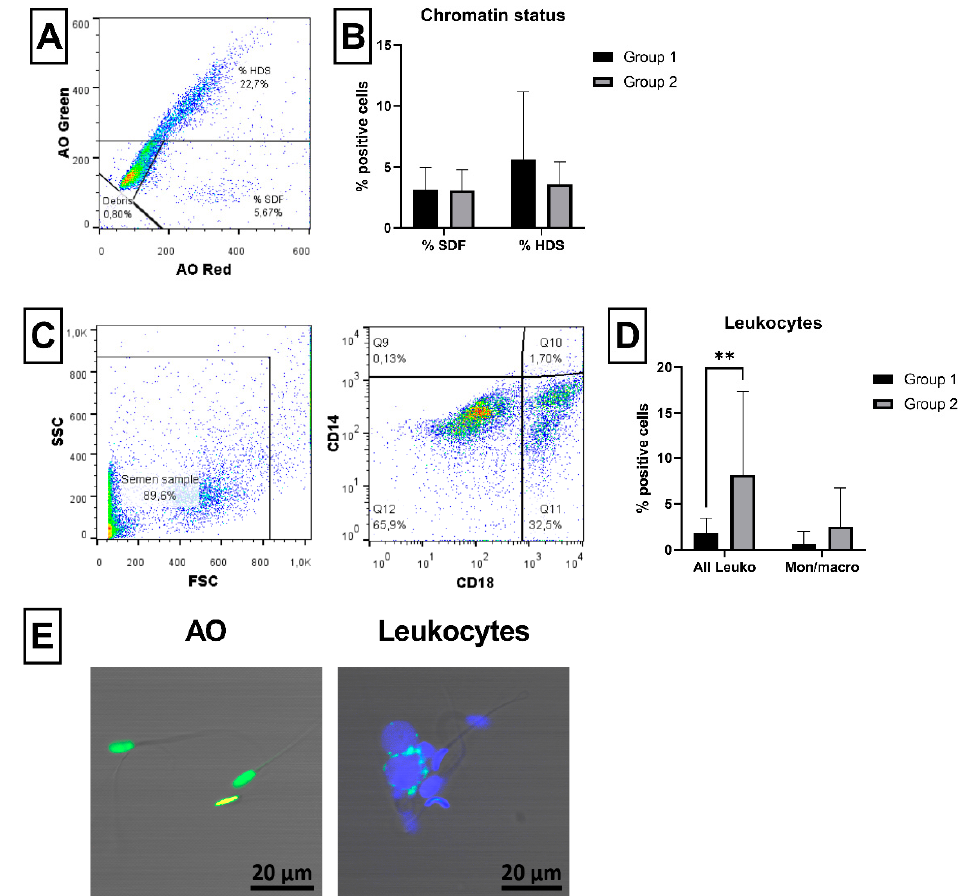
Figure 6. Evaluation of ram sperm chromatin damage and leukocytes occurrence. Illustrative flow- cytometric dot plots showing evaluation strategy of analyzed AO probe. Spermatozoa were evaluated in a linear scale of green FL1 channel and red FL3 channel, where spermatozoa bearing loose chromatin shifted fluorescence to red (% SDF) and immature spermatozoa showed high green fluorescence (% HDS) ( A ). Graph showing comparison of spermatozoa with fragmented DNA (% SDF) and spermatozoa with high DNA stainability (% HDS) in Group 1 and Group 2 ( B ). Illustrative flow- cytometric dot plots showing evaluation strategy of analyzed fluorescent antibodies. Spermatozoa and somatic cells excluded of dead cells (DRAQ7 + ) were gated using FSC/SSC, showed in green FL1 channel (CD18) and orange FL2 channel (CD14) and divided into four quadrants (Q) according to fluorescent signals ( C ). Graph showing comparison of all leukocytes (Q10: CD18 + /CD14 + and Q11: CD18 + /CD14 − ) and monocytes/macrophages alone (Q10: CD18 + /CD14 + ) detected in Group